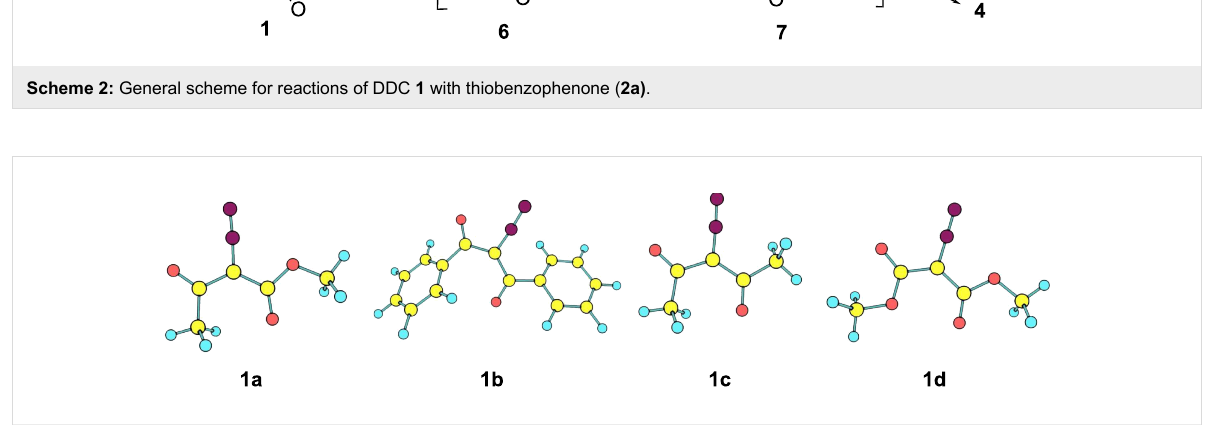
Figure 2: Optimized structures of the lowest energy Z , E -conformers of diazo compounds 1a–d .